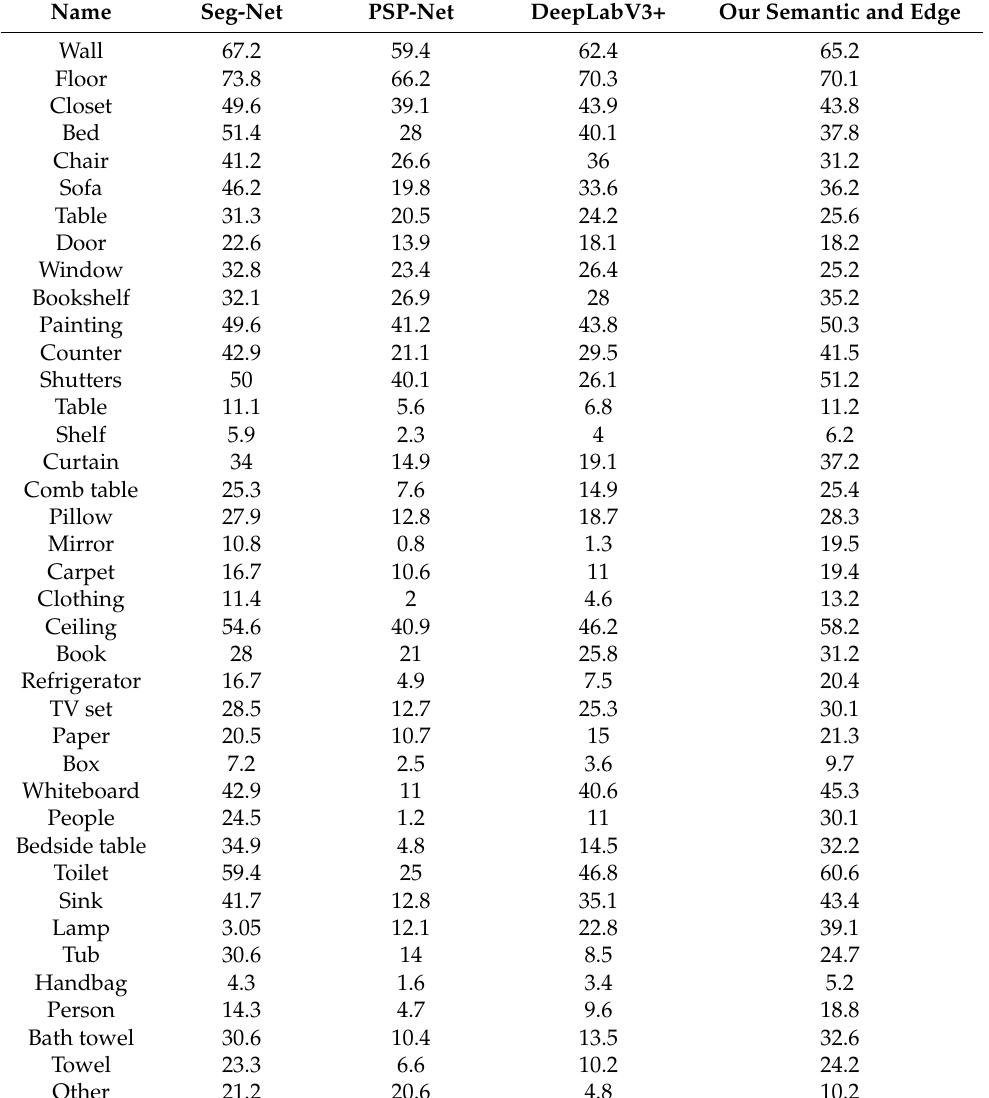
Table 3. MIOU comparison of different image segmentation